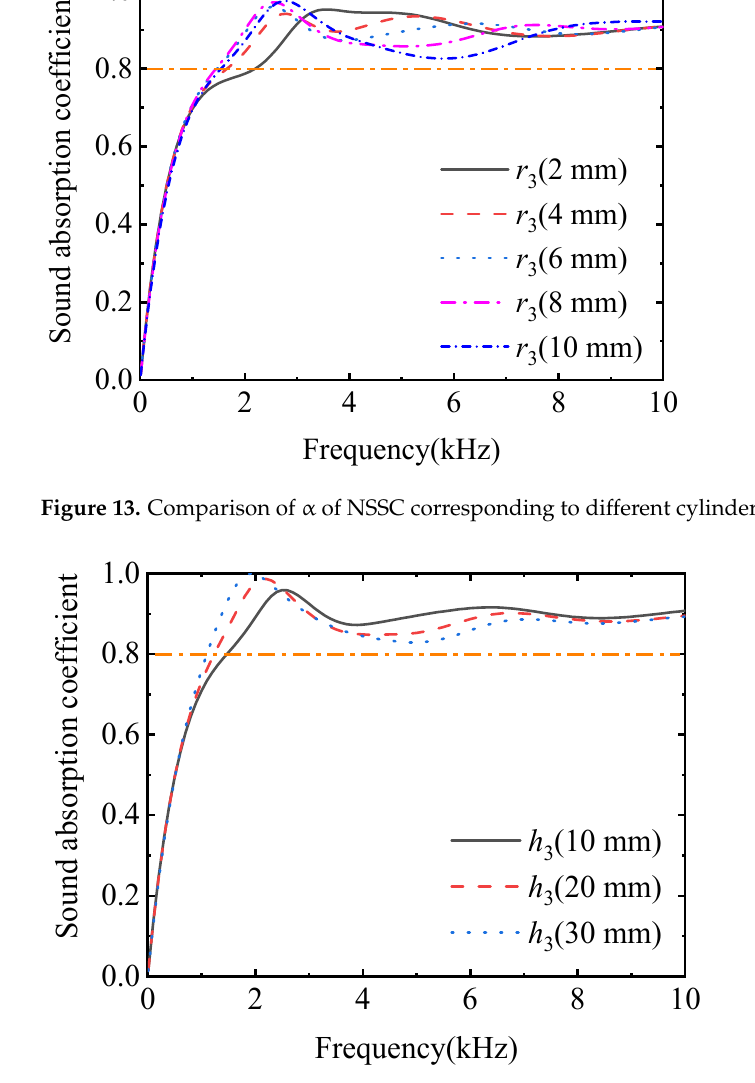
Figure 14. Comparison of α of NSSC corresponding to different cylinder heights.